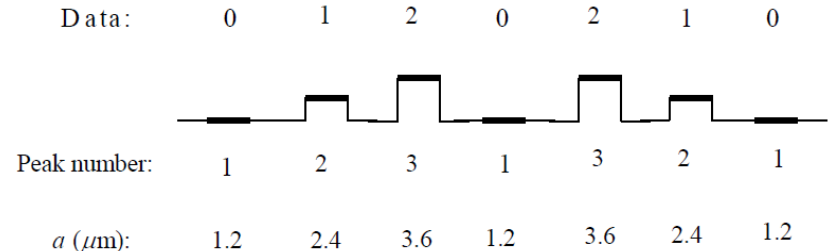
Figure 9. Illustration for the data encoding and transmission by controlling the slit width. The three-level data 0, 1, and 2 are related to the spectrum with peak number 1, 2, and 3, which can be obtained by varying width a .